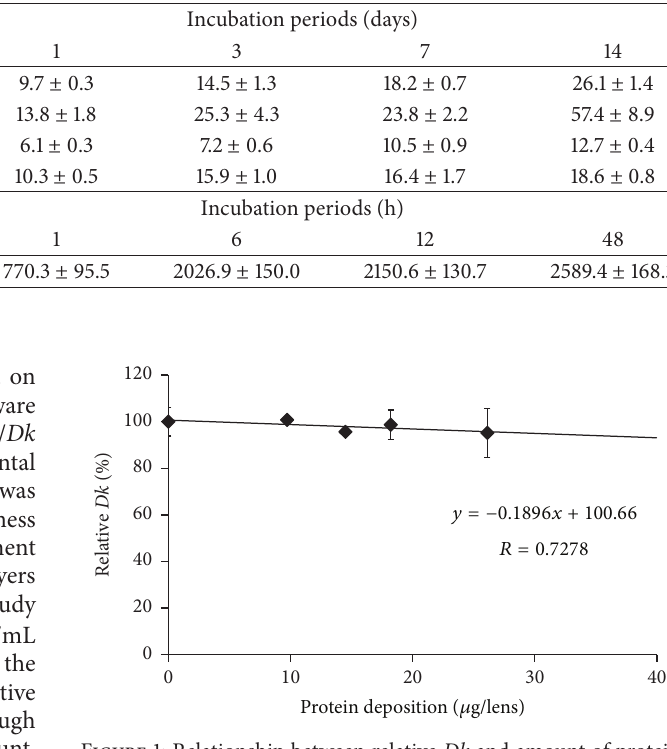
Figure 1: Relationship between relative Dk and amount of protein deposition on polymacon